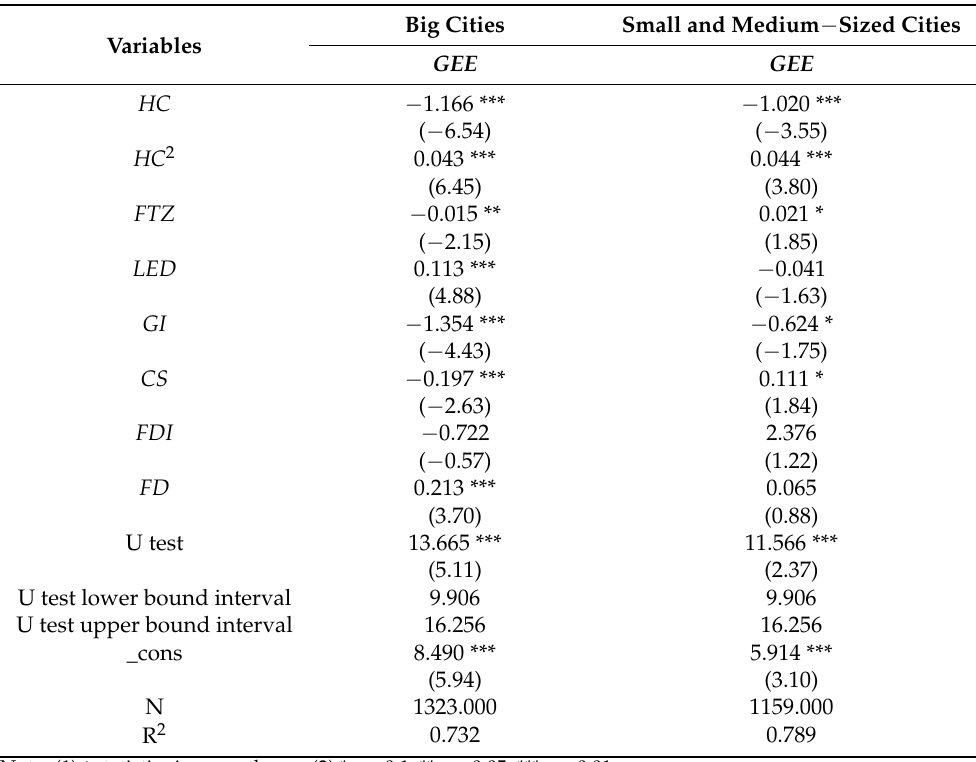
Table 8. Test of the relationship between HC and GEE for different city scale.